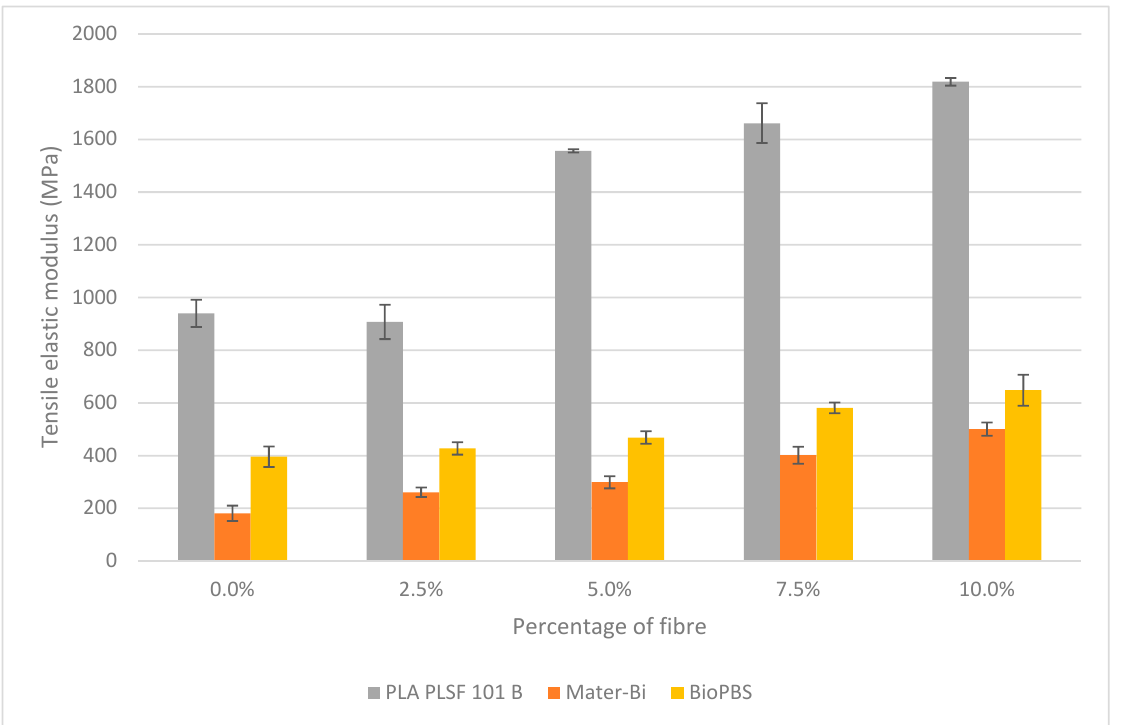
Figure 5. Comparison of the tensile elastic modulus of the 2nd generation compounds.